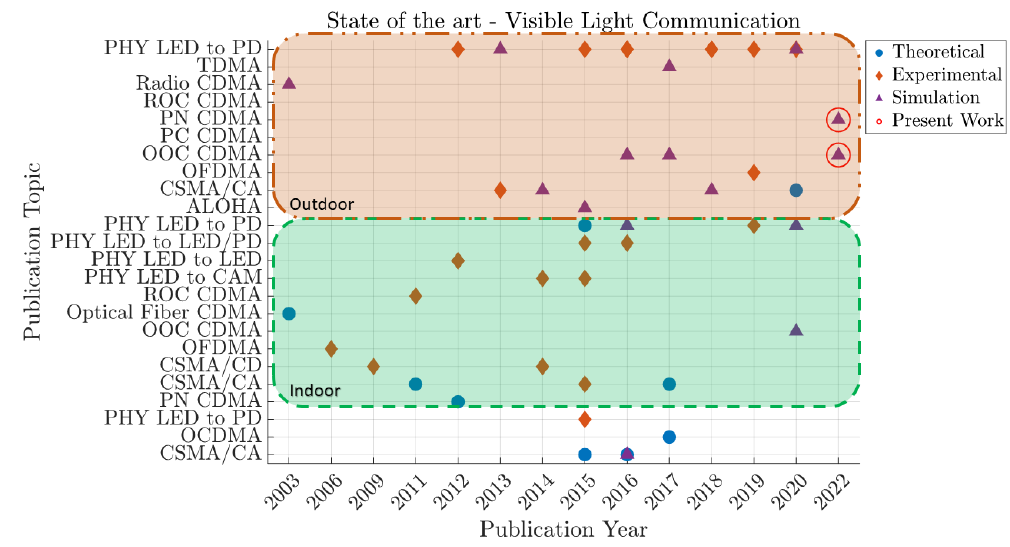
Figure 1. State of the Art of Vehicular VLC MAC